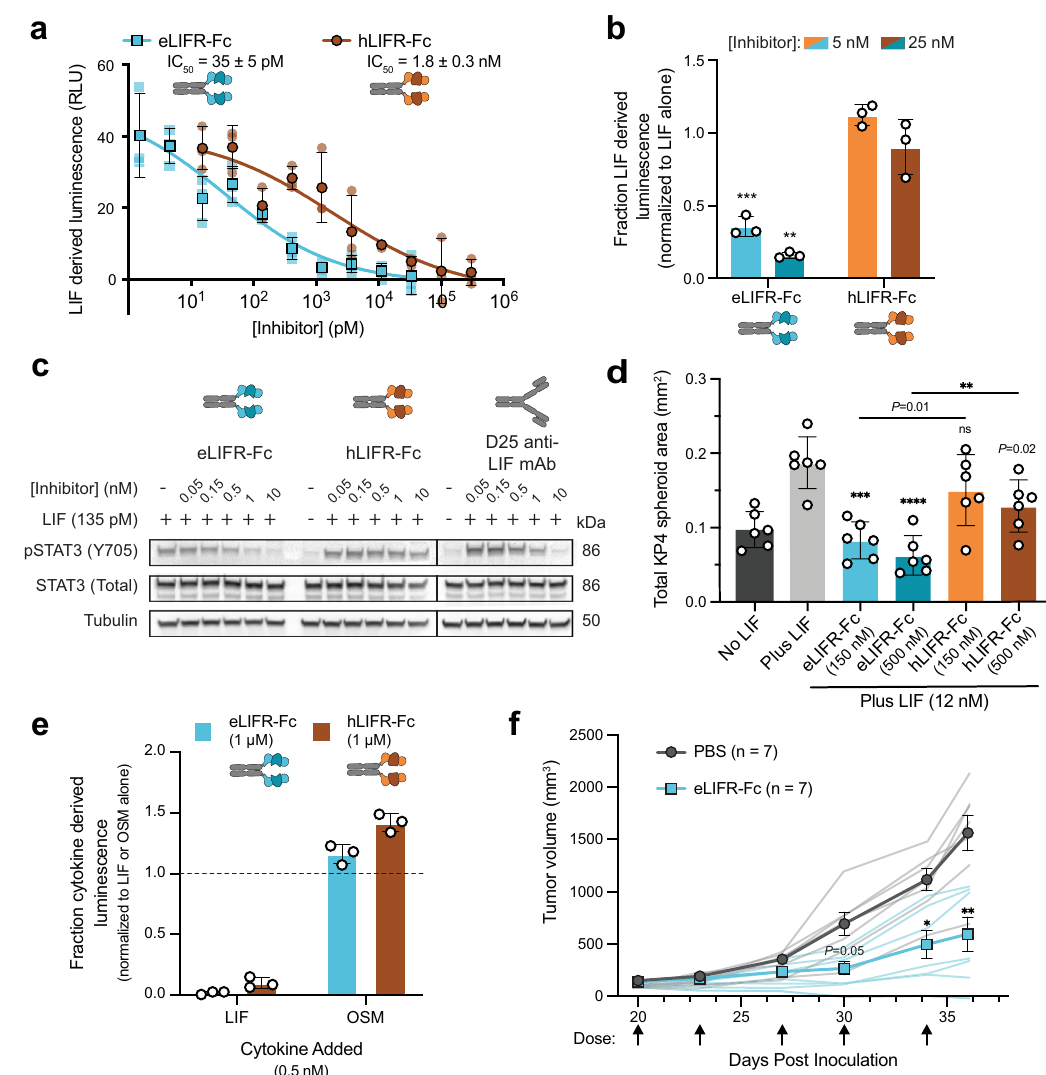
Fig. 4 eLIFR-Fc inhibits LIF activity in models of cancer. a eLIFR-Fc (blue squares) functionally inhibits LIF activity with a ~50-fold better IC 50 than hLIFR- Fc (brown circles) in HeLa STAT3 luciferase reporter cells. [LIF] = 20 pM. Data are the mean ± SD ( n = 3). Data from individual experiments are shown as faint symbols. b Normalized luminescence from HeLa STAT3 luciferase reporter cells incubated with 0.5 nM LIF for 1 h, followed by addition of eLIFR-Fc or hLIFR-Fc as indicated. ** P = 0.0025, *** P = 0.0002 compared to the corresponding hLIFR-Fc condition by two-tailed unpaired Student ’ s t test. Data are the mean ± SD ( n = 3). c Immunoblot of cell lysates from KP4 human PDAC cells incubated with LIF and/or each protein as indicated ( n = 1). Lines indicate lanes that were not adjacent on the original blot. d Total spheroid area of KP4 human PDAC cells, 1 week after seeding. Each data point represents an individual well of a 96-well plate; spheres were identi fi ed manually and the total area of all spheres in each well was quanti fi ed with ImageJ. ** P = 0.0042, *** P = 0.0001, **** P < 0.0001 compared to “ Plus LIF ” condition (for stars and P values above bars) or between hLIFR-Fc and eLIFR-Fc (indicated by horizontal lines) by two-tailed unpaired Student ’ s t test. Data are the mean ± SD ( n = 6). e High concentrations of eLIFR-Fc or hLIFR-Fc do not inhibit OSM signaling in HeLa STAT3 cells as compared to LIF. Raw luminescence, minus baseline luminescence, was normalized to the luminescence from the respective condition without inhibitor (dashed line). Data are the mean ± SD ( n = 3 for all except 3 nM LIF, where n = 2). f Treatment of human KP4 PDAC xenograft model with PBS (gray circles) or eLIFR-Fc (blue squares; 10 mg/kg, 2×/week). Dosing schedule indicated by arrows. P = 0.05; * P = 0.02; ** P = 0.009 by two-way ANOVA with Sidak ’ s multiple comparisons test. Data are the mean ± SEM ( n = 7). Data from individual mice are shown as faint lines. eLIFR-Fc does not effectively bind to other IL-6 family cyto- >2-fold greater aggregate spheroid area (Fig. 4d, Supplementary kines . Other IL-6 family member cytokines share LIFR and gp130 Fig. 5h). eLIFR-Fc mitigated LIF-driven spheroid formation, even at concentrations only twofold in excess of LIF (Supplementary co-receptors including oncostatin M (OSM), cardiotrophin-1 Fig. 5h), and signi fi cantly better than hLIFR-Fc (Fig. 4d, (CTF-1), and cardiotrophin-like cytokine factor 1 (CLCF-1) Supplementary Fig. 5h). eLIFR-Fc also signi fi cantly inhibited (Supplementary Fig. 2a) 40,41 . Flow cytometry analysis showed that yeast-displayed CBM I – Ig-like – CBM II domains of hLIFR or sphere formation by PANC1 cells, whereas hLIFR-Fc was eLIFR bind these cytokines very weakly, especially when com- ineffective (Supplementary Fig. 5i). Taken together, these data pared to LIF (Supplementary Fig. 6a). Af fi nity maturation of collectively establish that eLIFR-Fc is a potent functional inhibitor receptors toward a speci fi c ligand tends to improve or retain of LIF activity in PDAC cells. COMMUNICATIONS BIOLOGY| (2021) 4:452